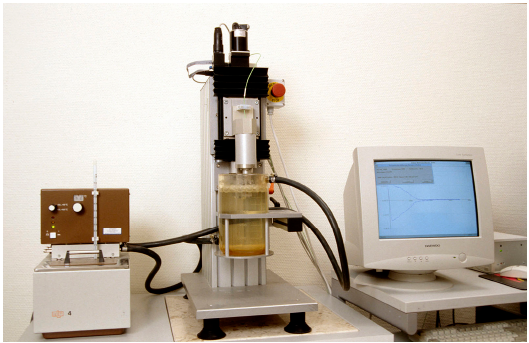
Figure 3. The Hado 2 material testing device has been portrayed with the temper-capable liquid container in the middle of the picture. To the left, the regulation-capable thermostat has been arranged. The Personal Computer is located in the right part of the picture.